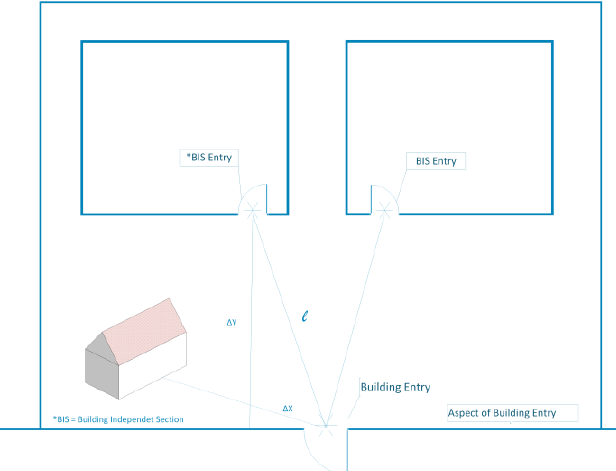
Figure 2. Representation of the geometric relationship between the building and the independent section